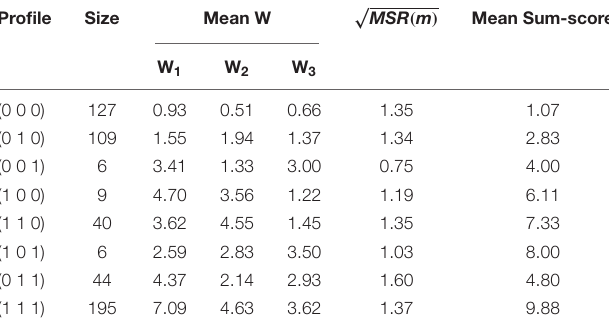
TABLE 3 | Classification by A-CDM.